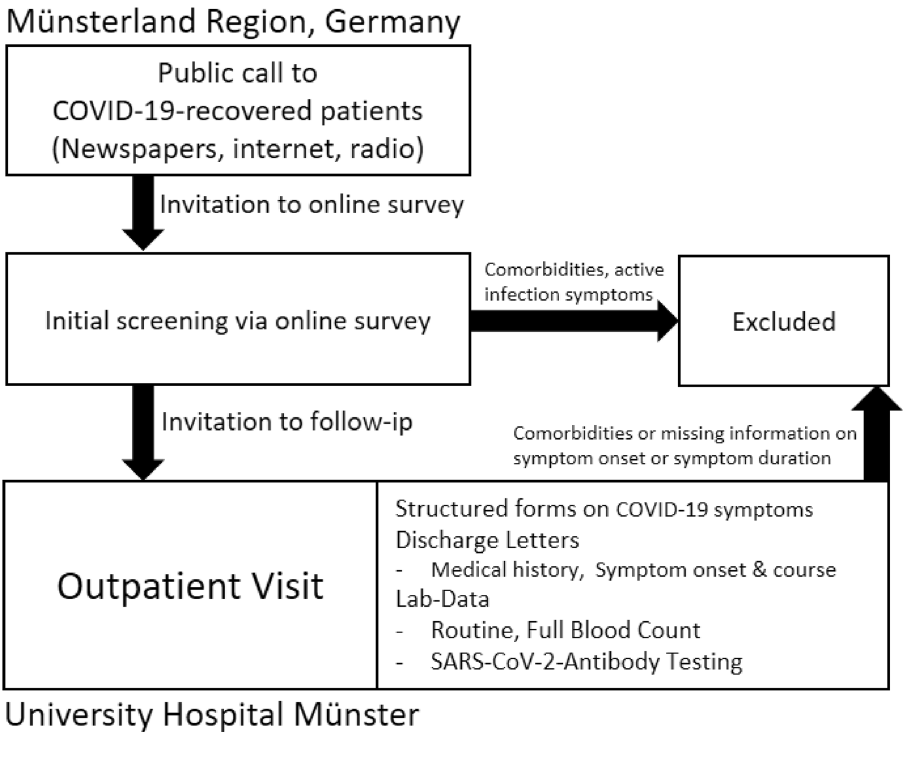
Figure 1. Inclusion of study